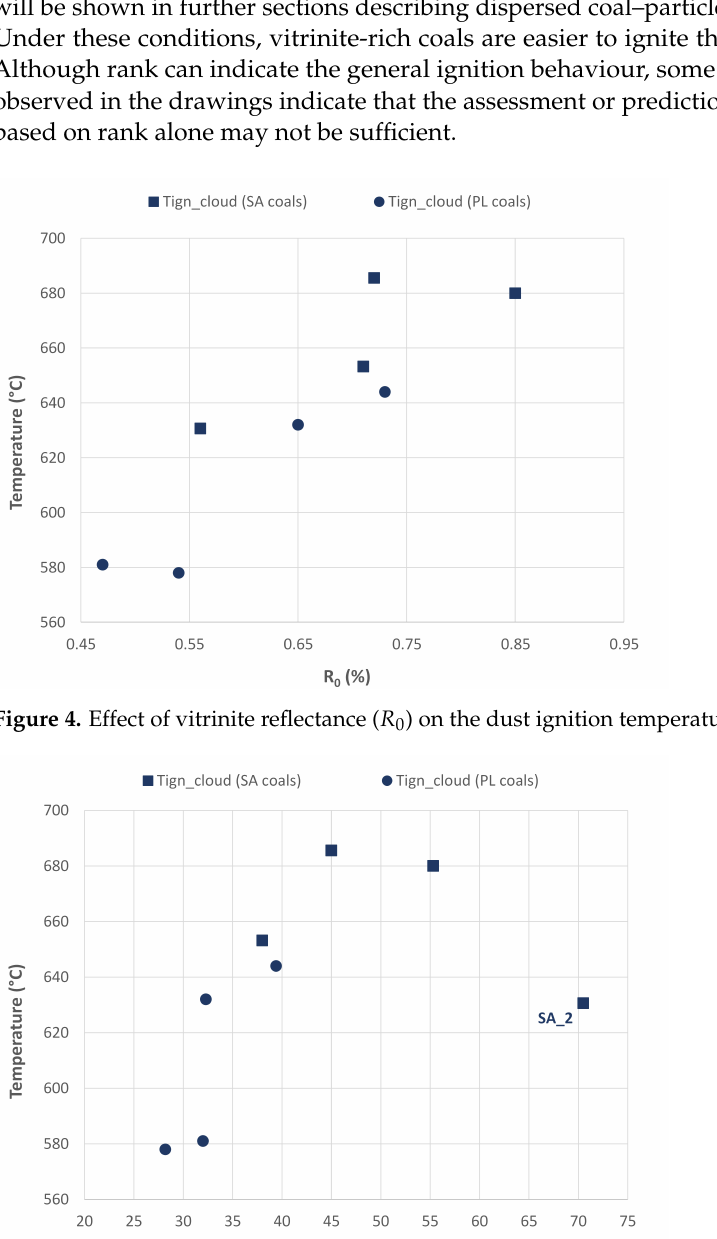
Figure 5. Effect of inertinite content of coals on the dust ignition temperature, T cloud